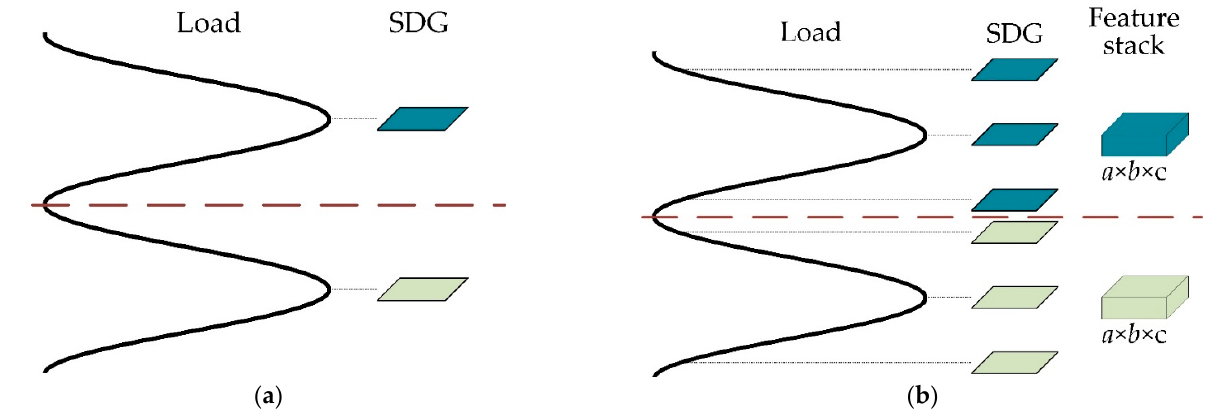
Figure 3. Strategies that form the SDGs to example features: ( a ) SDGs with the maximum load of cycles; ( b ) SDG sequences of load cycles.